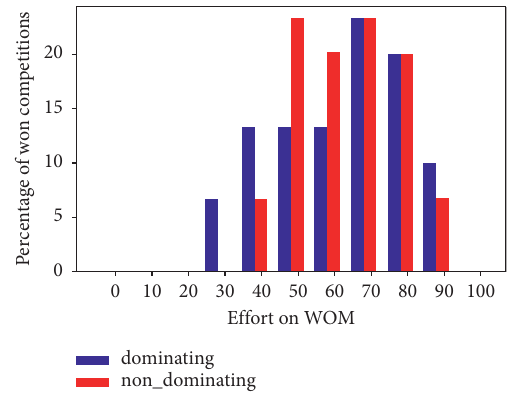
Figure 19: Percentage of winning competitions for 11 different